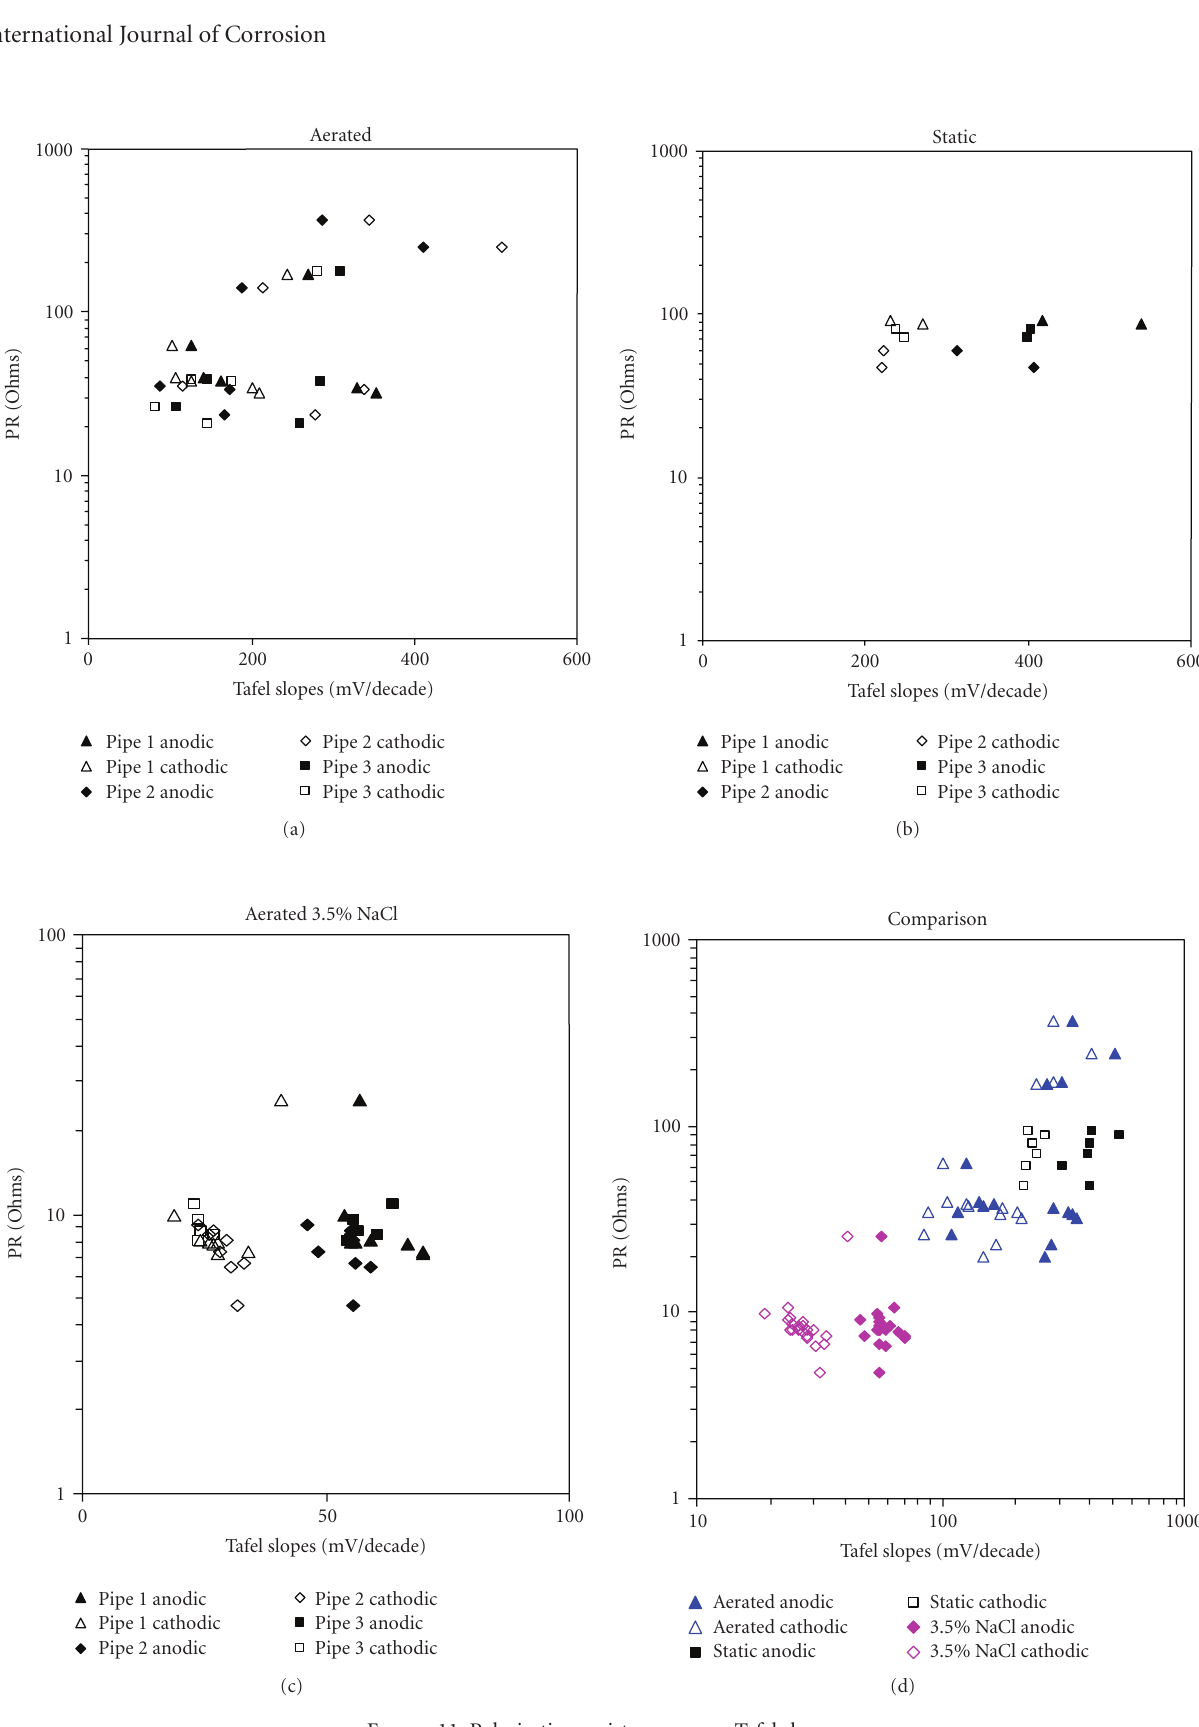
Figure 11: Polarisation resistance versus Tafel